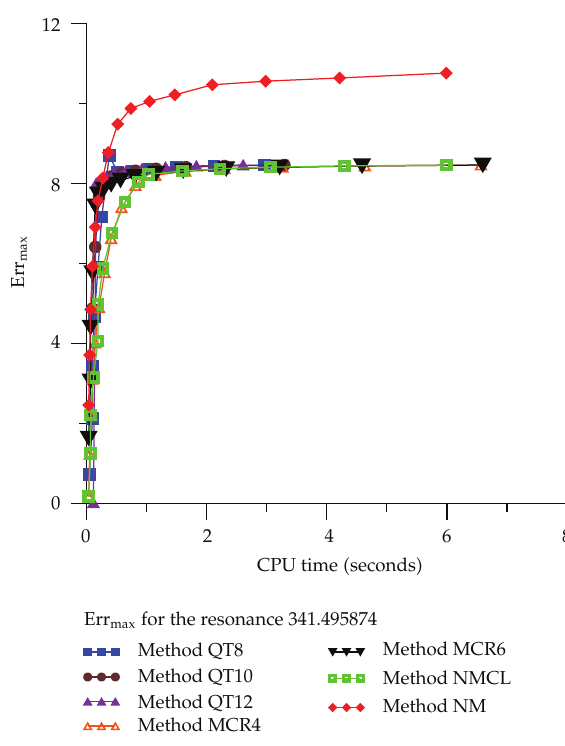
Figure 4: Accuracy (cid:4) digits (cid:5) for several values of CPU Time (cid:4) in seconds (cid:5) for the eigenvalue E 2 (cid:6) 341 . 495874. The nonexistence of a value of accuracy (cid:4) digits (cid:5) indicates that for this value of CPU, accuracy (cid:4) digits (cid:5) is less than